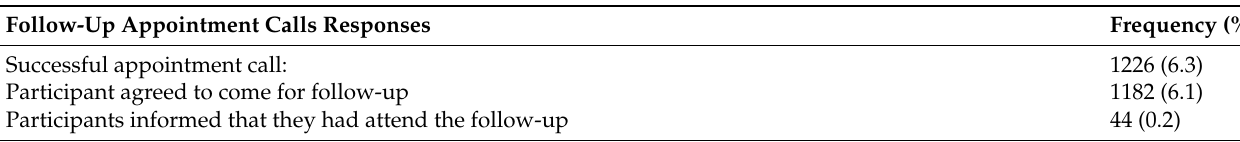
Table 1. Follow-up appointment calls responses of TMC participants residing in the Kuala Lumpur and Selangor area, Malaysia, March through May 2019 (N =